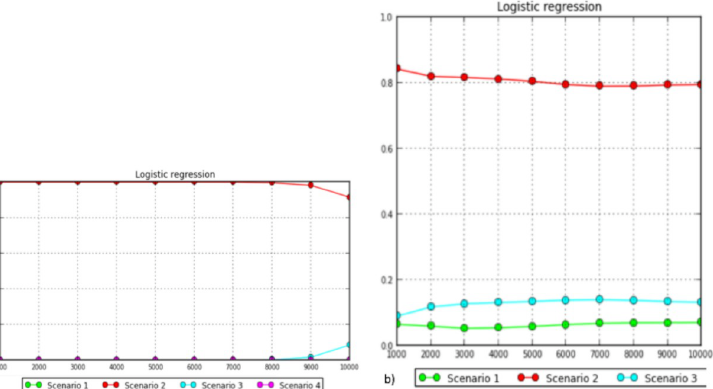
Fig 10. Logistic regression analysis the scenarios inferred using DIYABC: a) mtDNA; b) autosomal SNP markers.